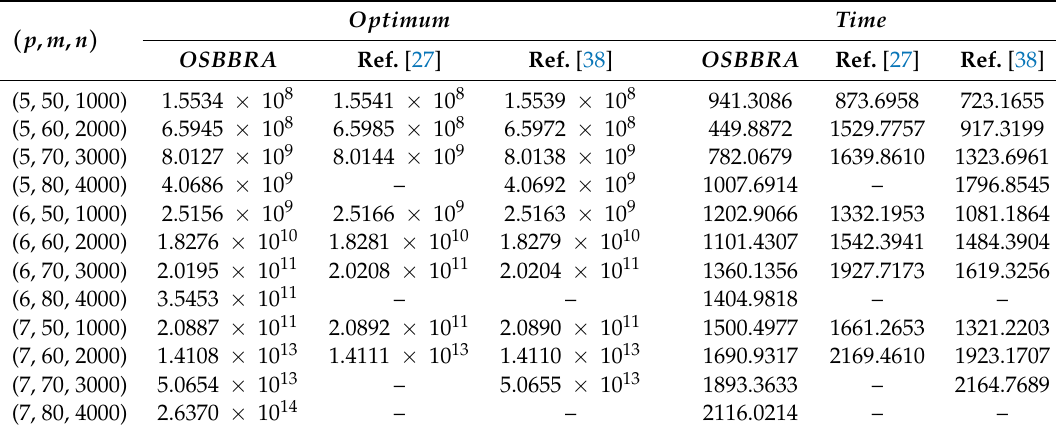
Table 3. The average result of 10 high-dimensional random problems